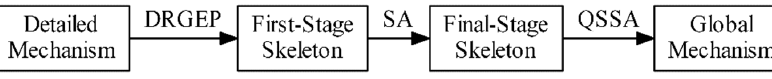
Figure 1. Flowchart of mechanism reduction.